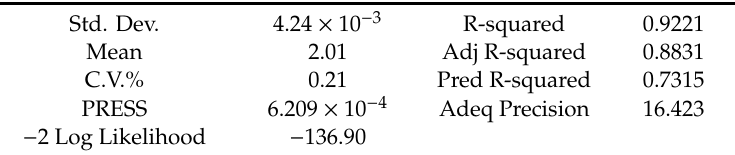
Table 7. Predicted R-square vs. adjusted R-square.